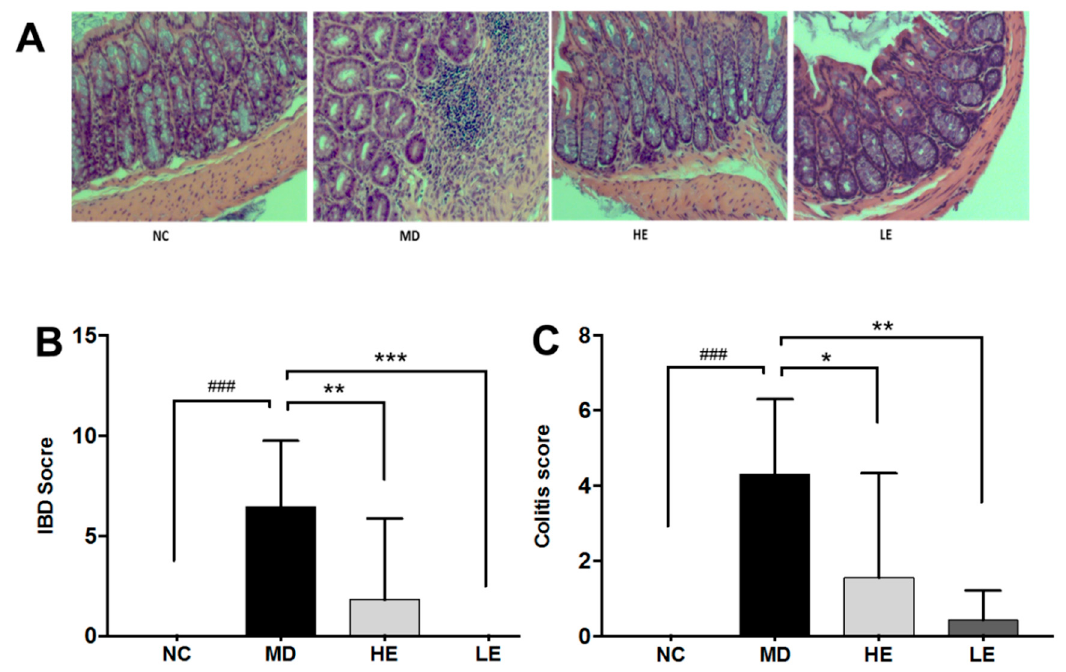
Figure 3. Effect of EGCG treatment on histopathologic changes in DSS-induced colitis . Hematoxylin and eosin (H & E) stained images of representative histopathologic changes in the four groups of mice are shown ( A ). Two different histopathologic scores were used to evaluate the histopathologic changes, namely inflammatory bowel disease (IBD) score ( B ) and colitis score ( C ). Both high- and low-dose EGCG treatment significantly decreased both the IBD score and the colitis score. H & E: Hematoxylin and eosin, IBD: Inflammatory bowel disease, NC: Normal control group, MD: Colitis model group, HE: High-dose EGCG group, LE: Low-dose EGCG group. Data are presented as mean ± standard deviation. * p < 0.05 vs. MD, ** p < 0.01 vs. MD, *** p < 0.001 vs. MD, # p < 0.05 vs. NC, ### p < 0.001 vs. NC.